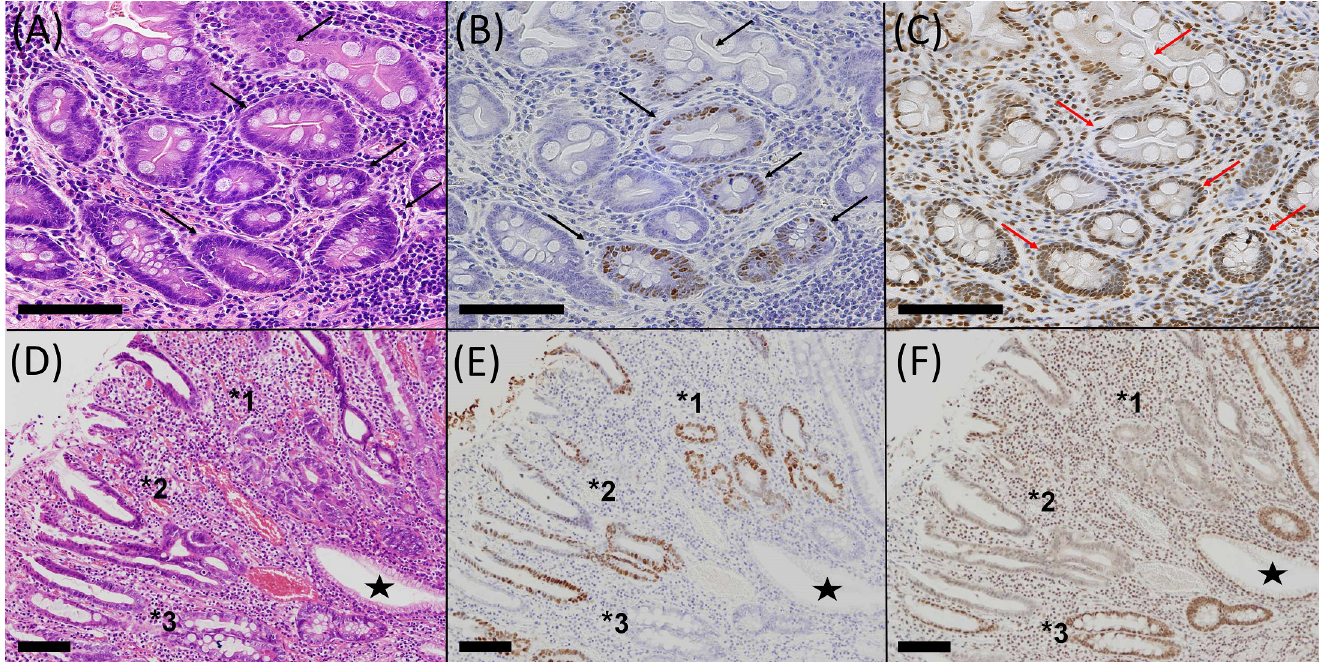
Fig 1. EBER-positive epithelial cells in non-neoplastic mucosa. Two types of EBER-positive cells are shown: the metaplastic glandular type (A–C) and the surface degenerative type (D–F). Glandular cells of intestinal metaplasia without morphological atypia (arrows, A) show positive nuclear signals for EBER (arrows, B). Of note, these cells retained nuclear ARID1A expression (arrows, C). Surface epithelial cells in the upper or middle portion of the mucosa propria with degenerative changes and mild nuclear atypia ( � 1–3, D) show positive nuclear signals for EBER ( � 1–3, E). The nuclei of these cells were negative for ARID1A ( � 1, 3, F), and EBER-positive cells were included in the lesions of ARID1A-lost epithelial cells ( � 2, E–F). Asterisks indicate control epithelial cells showing EBER-negative and ARID1A-positive nuclei. A and D, hematoxylin–eosin staining; B and E, EBER in situ hybridization; and C and F, ARID1A immunostaining. Scale bar, 100 μ m.